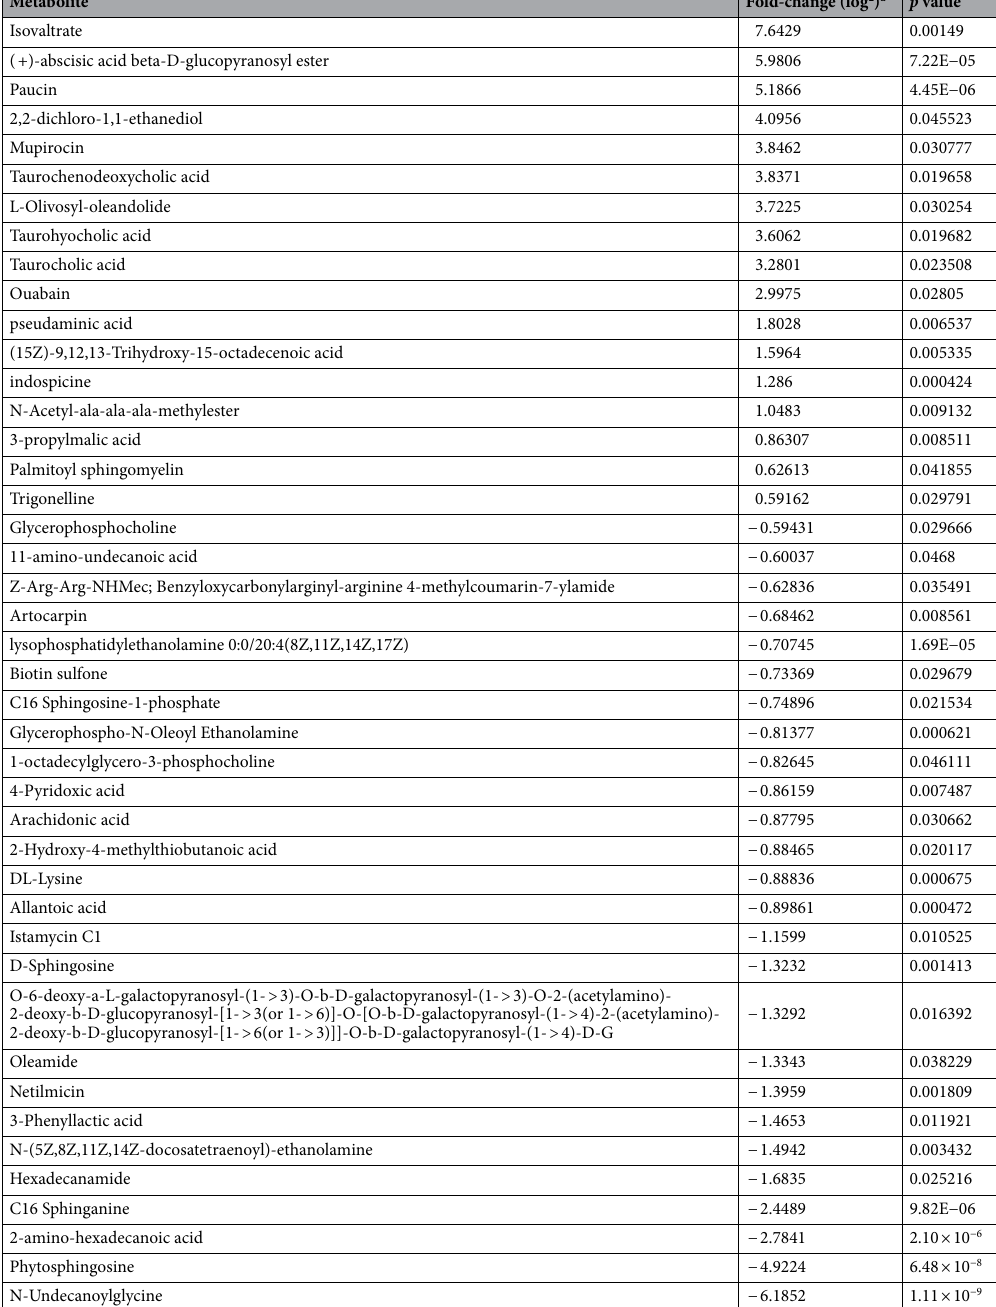
Table 2. List of metabolites in TRF against HFD. a Fold change values described are the ratio of TRF/HFD. The values are arranged from highest ratio (up-regulated) to the lowest